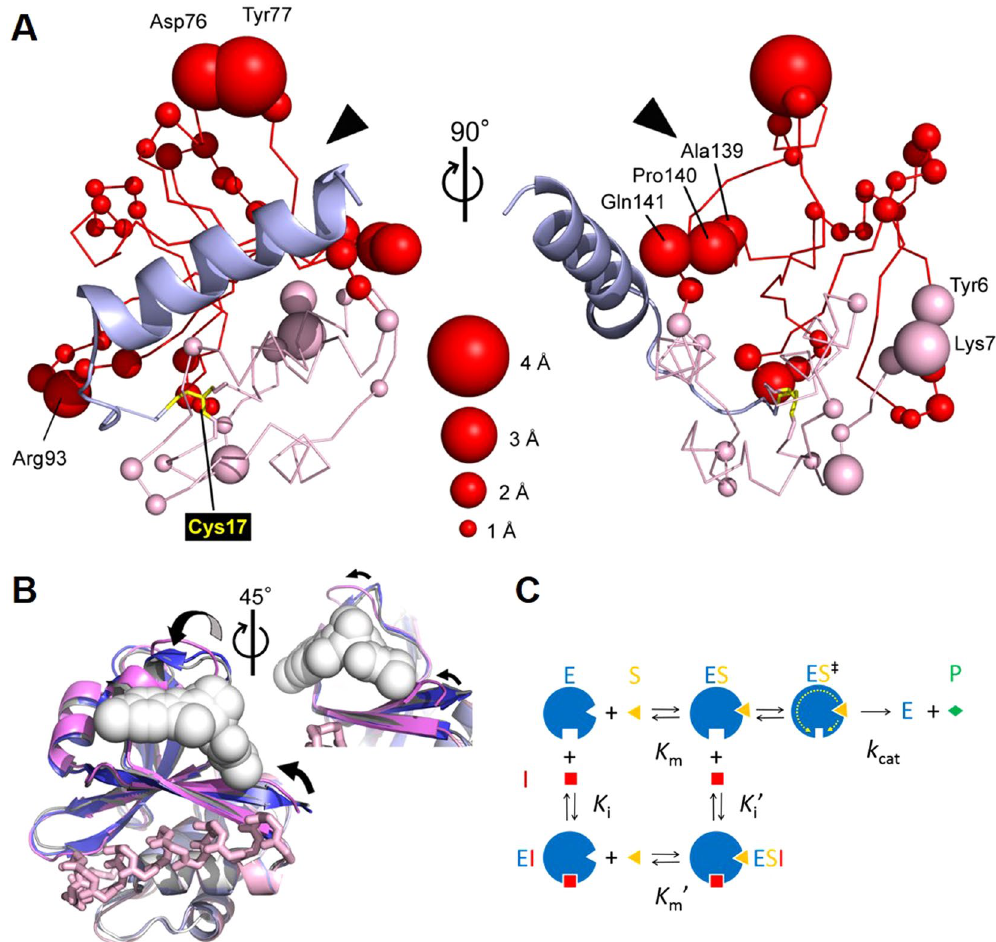
Figure 4. Structural Changes of the Allosteric Site and the Proposed Inhibition Mechanism. ( A ) The acyl- intermediate model of MuPEP1-MuComC, in which the thioester bond is formed between Cys17 of PEP and the cleavage site Gly of MuComC (blue), was obtained by molecular dynamics simulation 18 . The positional difference for each C α atom between the free MuPEP1 (PDB ID code 3K8U) and the acyl-intermediate model was calculated and shown. Residues that showed significant differences ( ≥ 1 Å) are indicated as spheres, of which the diameters define relative difference distances. Arrowheads indicate the binding site of Compound 2. The N-terminal (1–62) and the C-terminal (63–150) subdomains are colored in light and deep tones, respectively. Arg93, which shows a large structural shift, is located at the entrance to the narrow cleft of the Gly–Gly binding site. The structural changes around Arg93 upon formation of the acyl-intermediate might be propagated and amplified to cause large structural changes around the remote Compound 2-binding site. ( B ) Superimposition of the overall structures of the tMuPEP1-Compoud 2 complex (gray), the free MuPEP1 (blue), and the acyl-intermediate model of MuPEP1-MuComC 18 (pink). MuComC and Compound 2 are shown as stick and sphere models, respectively. The distinction between light and deep tones is the same as in ( A ). ( C ) The reaction scheme of MuPEP1 and mechanism for non-competitive inhibition. E, enzyme; S, substrate; P, product; I, inhibitor; K m , Michaelis constant; k cat , turnover number; and K i , inhibition constant. After the substrate binding step, the reaction proceeds via a transition state (ES ‡ ), in which the space of a pocket on the protein surface is squeezed (broken arrows). The inhibitor binds to this pocket and inhibits the enzyme- catalyzed reaction by preventing structural changes. In the non-competitive inhibition model, K i ′ is supposed to be the same as K i